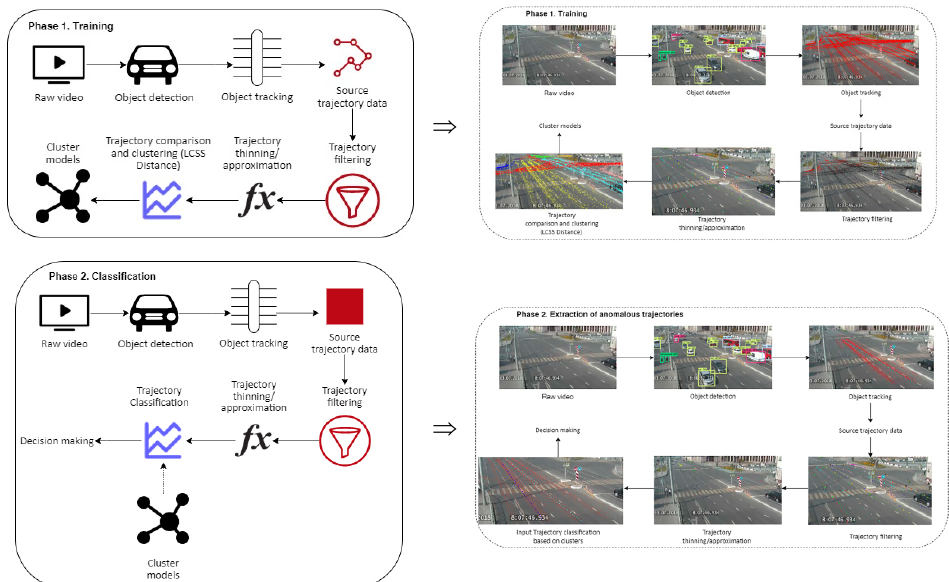
Figure 4. The main workflow of the suggested approach.